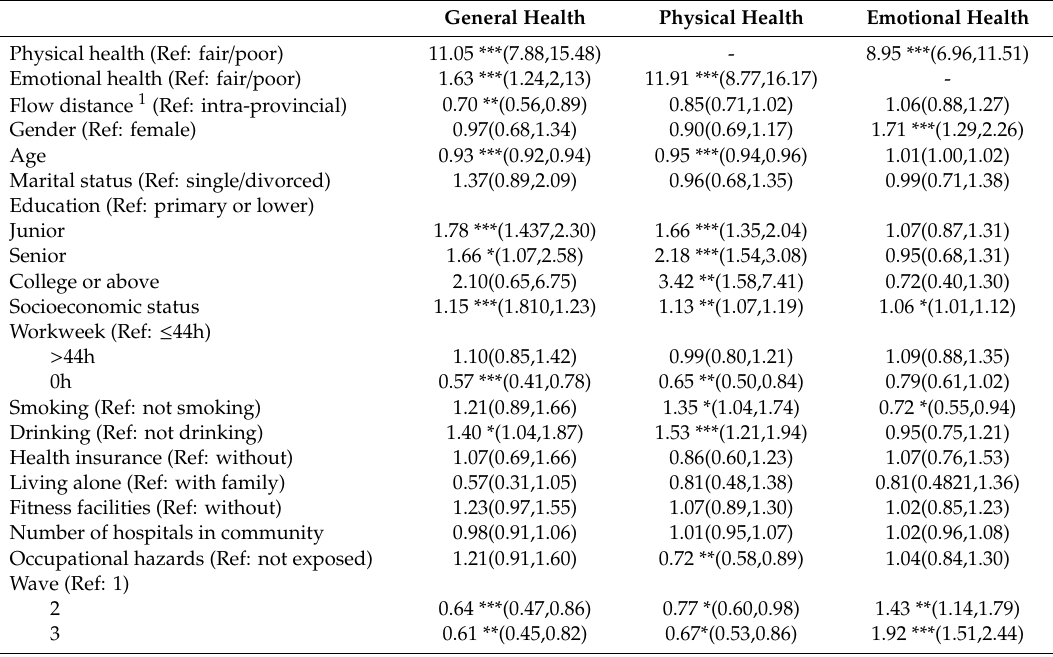
Table A2. Relevant factors a ff ecting health of returned